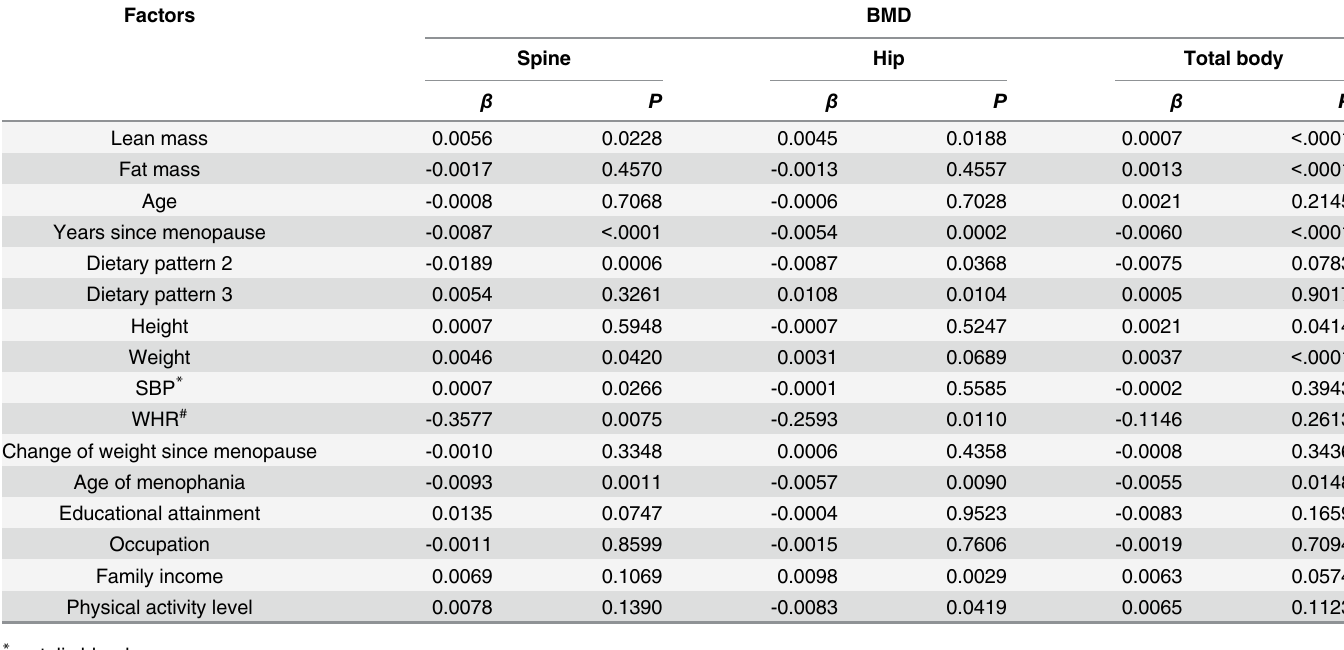
Table 5. The results from linear mixed model of the primary variables on BMD of the spine, hip, and the total body: 2-year follow-up data.